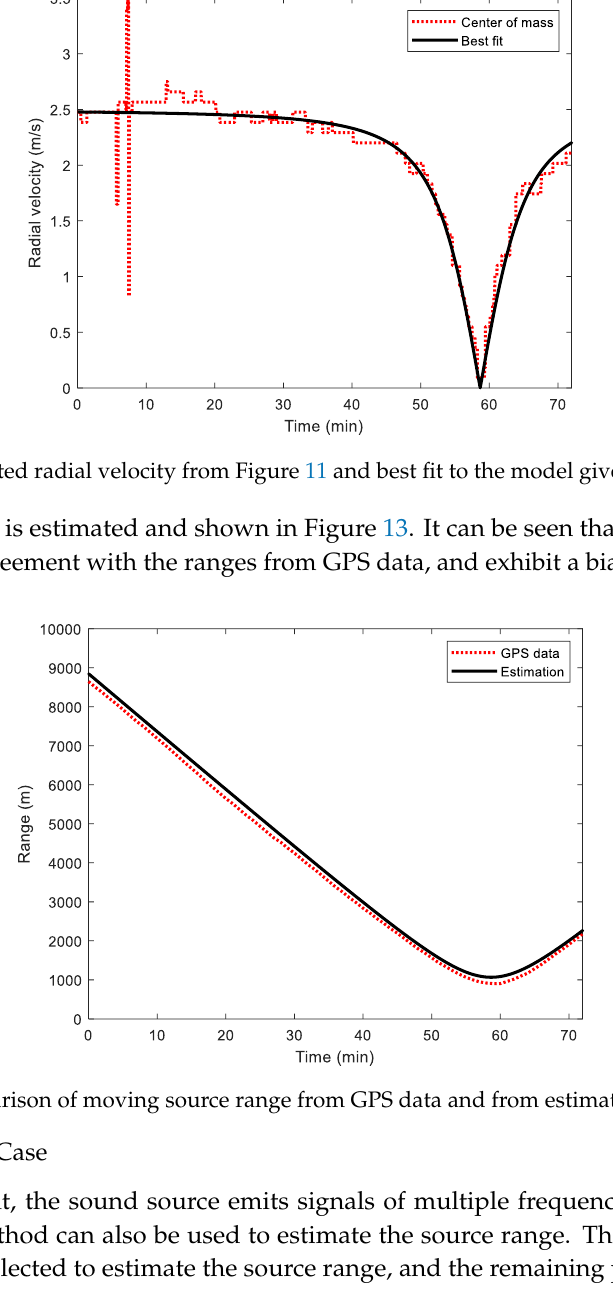
10 of 13 Figure 11. Estimated source velocities versus time. The best fit between the model of radial velocity given in Equation (1) and the estimated source velocity can be obtained using the least squares criterion, as shown in Figure 12. This provides a range and time of CPA of 0